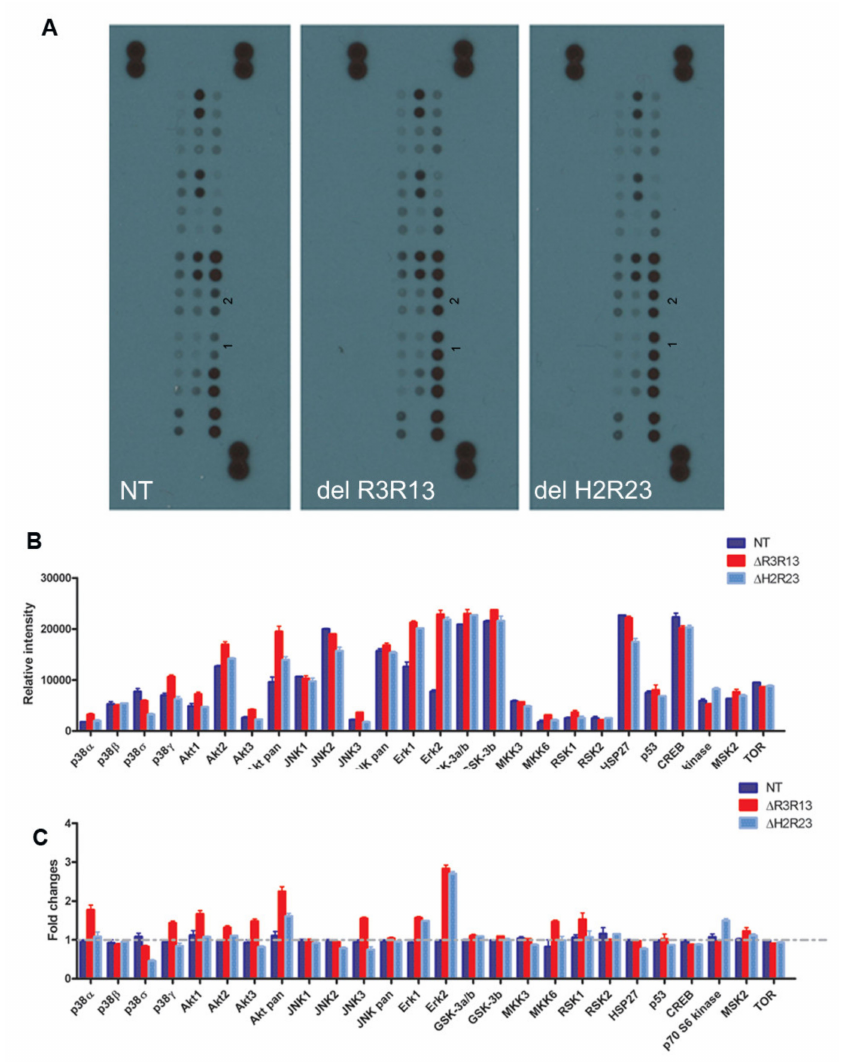
Figure 5. Signalling pathways involved in the e ff ect of the mini-dystrophins on DMD muscle- derived cells. Non-transduced cells (NT), GFP + cells purified from LV–SFFV– ∆ R3R13–GFP or LV–SFFV– ∆ H2R23–GFP-transduced cells were expanded and analysed with a human phosphor-MAPK array kit ( A ). Data shown are from a 1 min exposure to X-ray film. 1 and 2 in each blot denote the phosph-Erk2 and phosph-Erk1 signals respectively. Relative intensity measurements show expression levels of the 26 MAPKs in each sample ( B ), as well as by fold changes of each kinase against non-transduced cells in experimental groups ( C